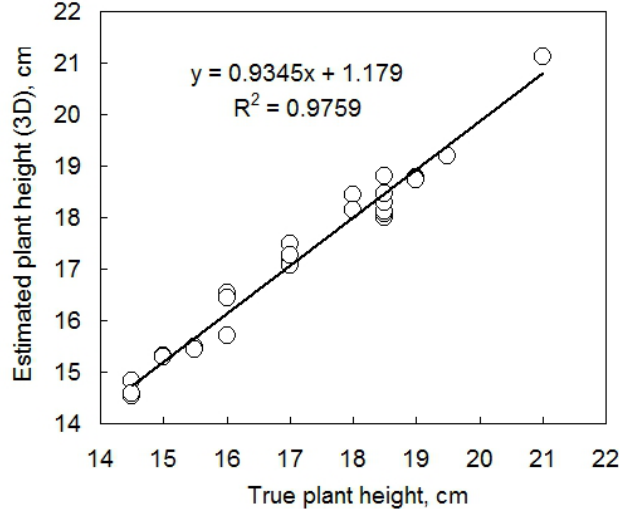
Figure 6. Validation of measurements of plant height. Twelve young pepper plants were measured daily for five consecutive days. The interpolating line represents a linear regression optimized by Microsoft